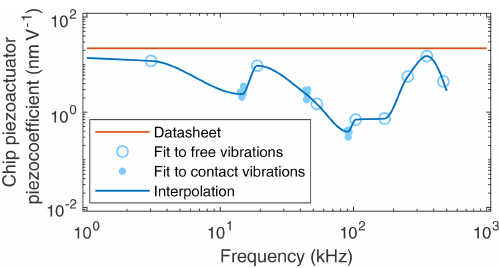
Figure 11. Frequency response of the sensitivity of the piezoactu- ator used in this work: sensitivity given in the datasheet (red line); values obtained by fitting the vibration model to measured reso- nance peaks of the sensor without contact (open blue circles) and with contact (filled blue circles) and interpolation through these val- ues (blue line). The data points with contact represent 14, 10, and 10 measurements for the first, second, and third modes with stan- dard deviations of the mean values of 3% to